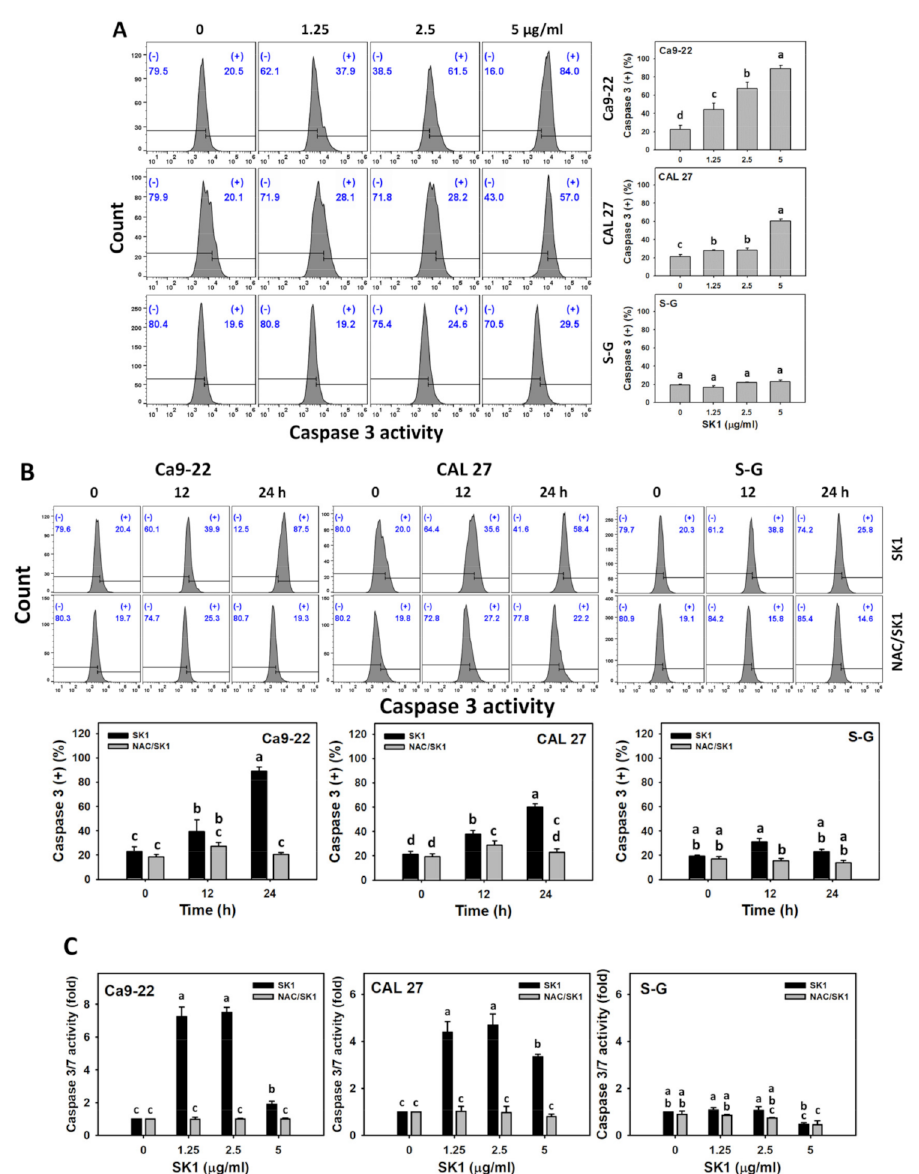
Figure 4. Apoptosis effects (flow cytometry-detected caspase 3 and luminescence-detected